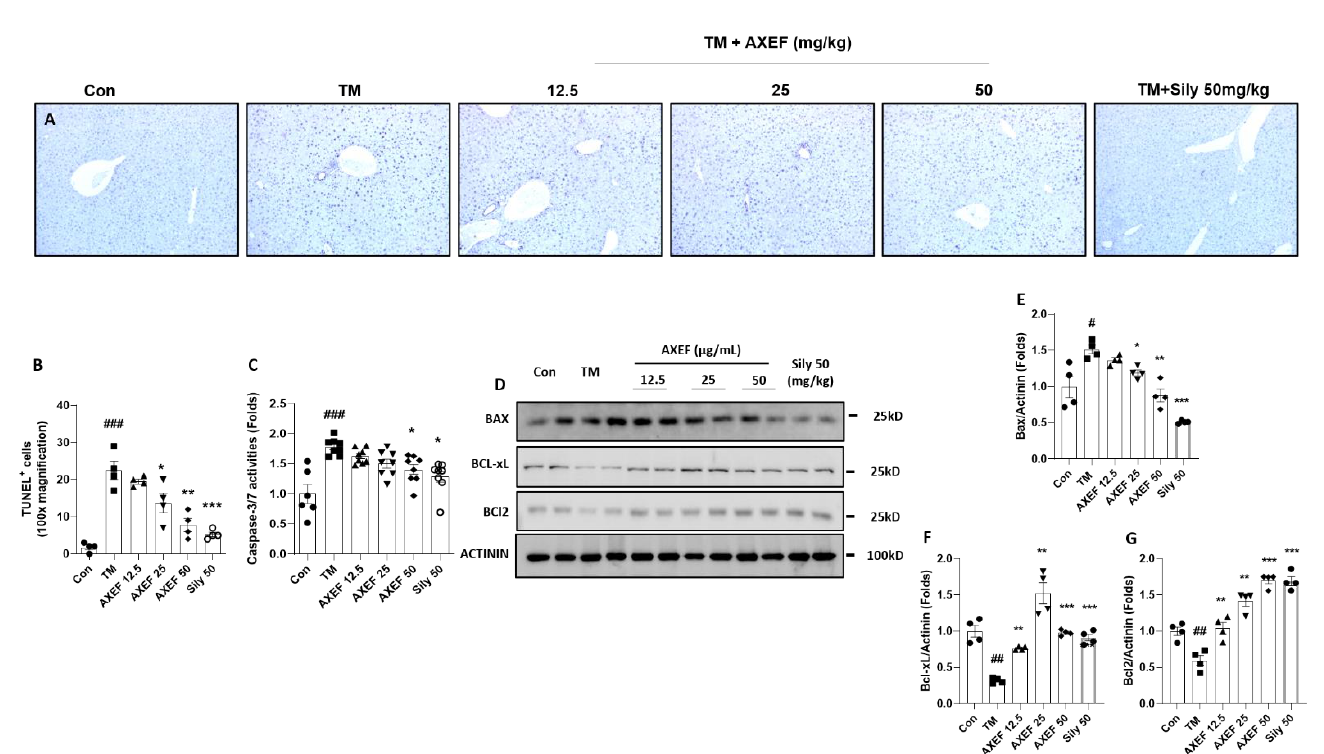
Figure 4. Anti-apoptotic effects of AXEF on the ER stress-induced NASH mouse model. ( A ) TUNEL assay and ( B ) quantitative analysis of TUNEL positive signal through the liver tissue. ( C ) Hepatic protein levels of caspase-3/7 activities. ( D ) Western blot analysis of apoptosis-related proteins BAX, BcL-xL, and BcL-2 in the hepatic protein lysates. ( E–G ) Quantitative analyses of Western blot. Data are expressed as the mean ± SD (n = 4 for TUNEL assay and Western blot analysis; n = 6–8 for each group for caspase-3/7 activities). # p < 0.05; ## p < 0.01; ### p < 0.001 for the Con vs. TM, * p < 0.05; ** p < 0.01; *** p < 0.001 for TM vs. AXEF or Sily 50. Images were captured using light microscopy (100× magnification).